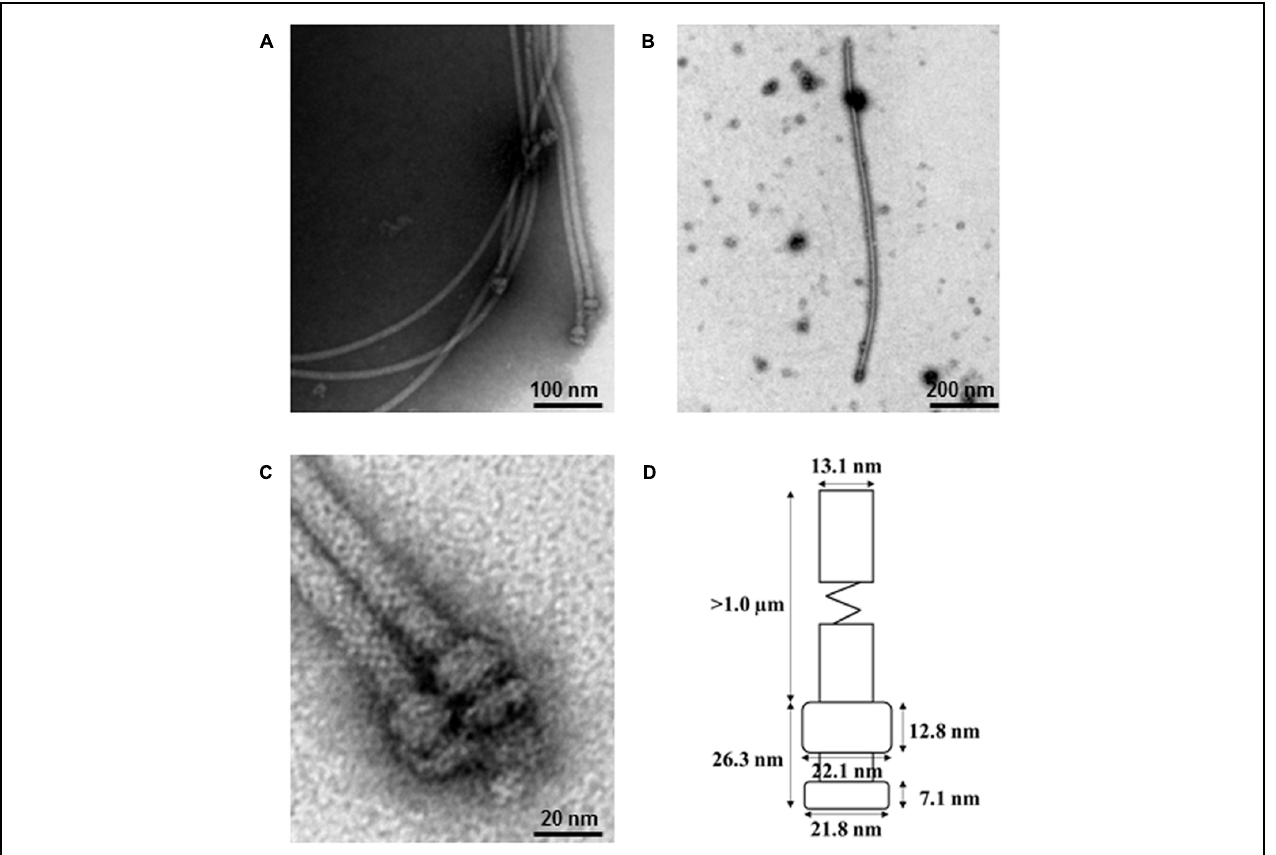
FIGURE 2 | Electron micrograph of purified type III secretion complexes from P. fluorescens 2P24. (A,B,C) Purified type III secretion complexes at different magnifications. The sample was obtained from the lower fraction of a 30% CsCl gradient centrifugation and observed by TEM. Scale bars as indicated in the